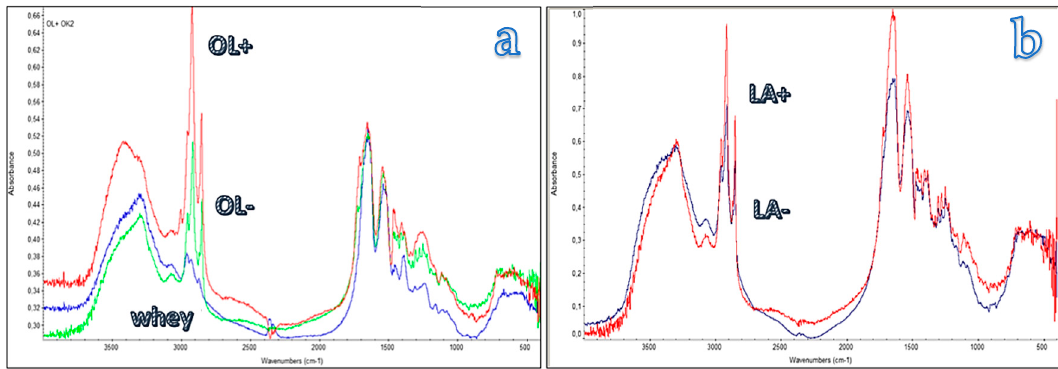
Figure 5. Infrared spectrum of the pure whey protein (green spectrum in ( a )), and of whey modified with oleic ( a ) and lauric ( b ) groups having different degree of modification.